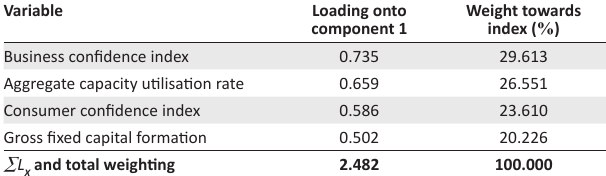
TABLE 6: Component loadings for South African financial confidence levels.